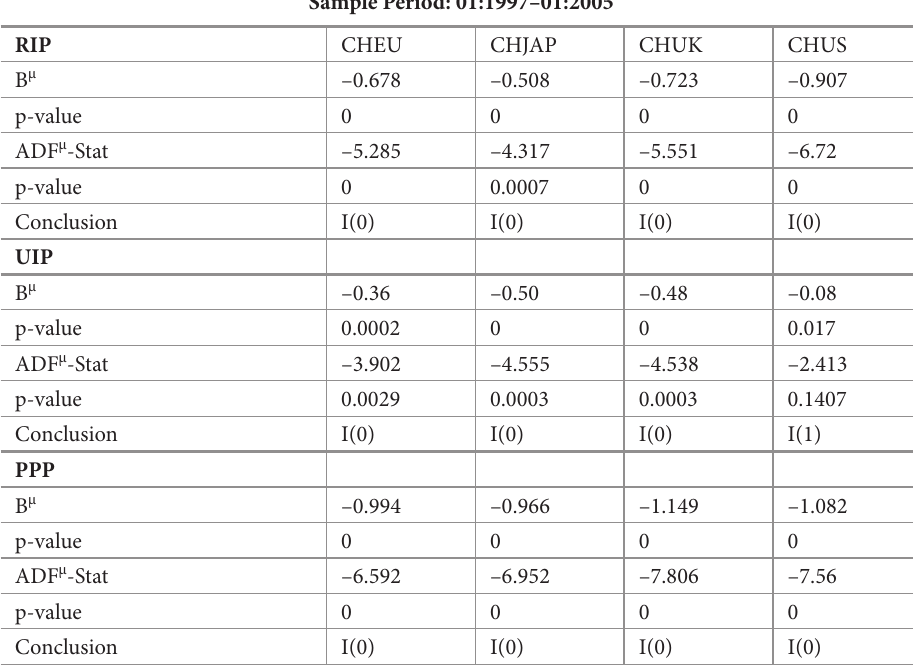
table 2. Summary of ADF unit root test for parity conditions sample period: